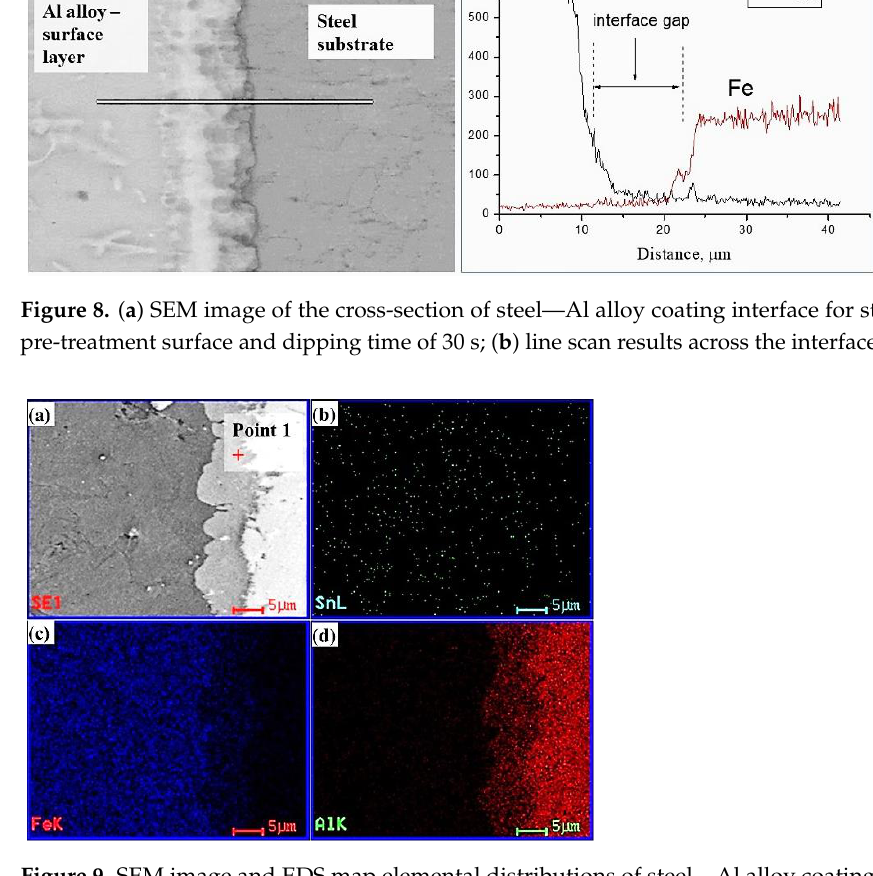
Figure 8. ( a ) SEM image of the cross-section of steel — Al alloy coating interface for steel with flux pre-treatment surface and dipping time of 30 s; ( b ) line scan results across the interface.